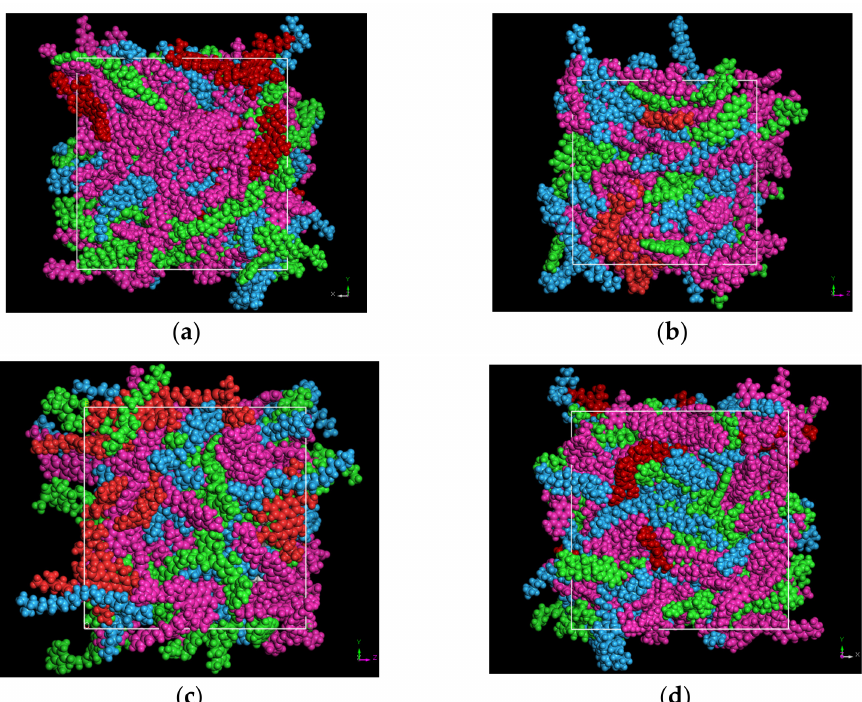
Figure 5. Molecular models of virgin asphalt ( a ), RPE-modified asphalt ( b ), CNT/RPE-modified asphalt ( c ) and the morphology of virgin asphalt after initial relaxation ( d ) (red indicates asphaltenes, green indicates resins, pink indicates aromatics and blue indicates saturates).